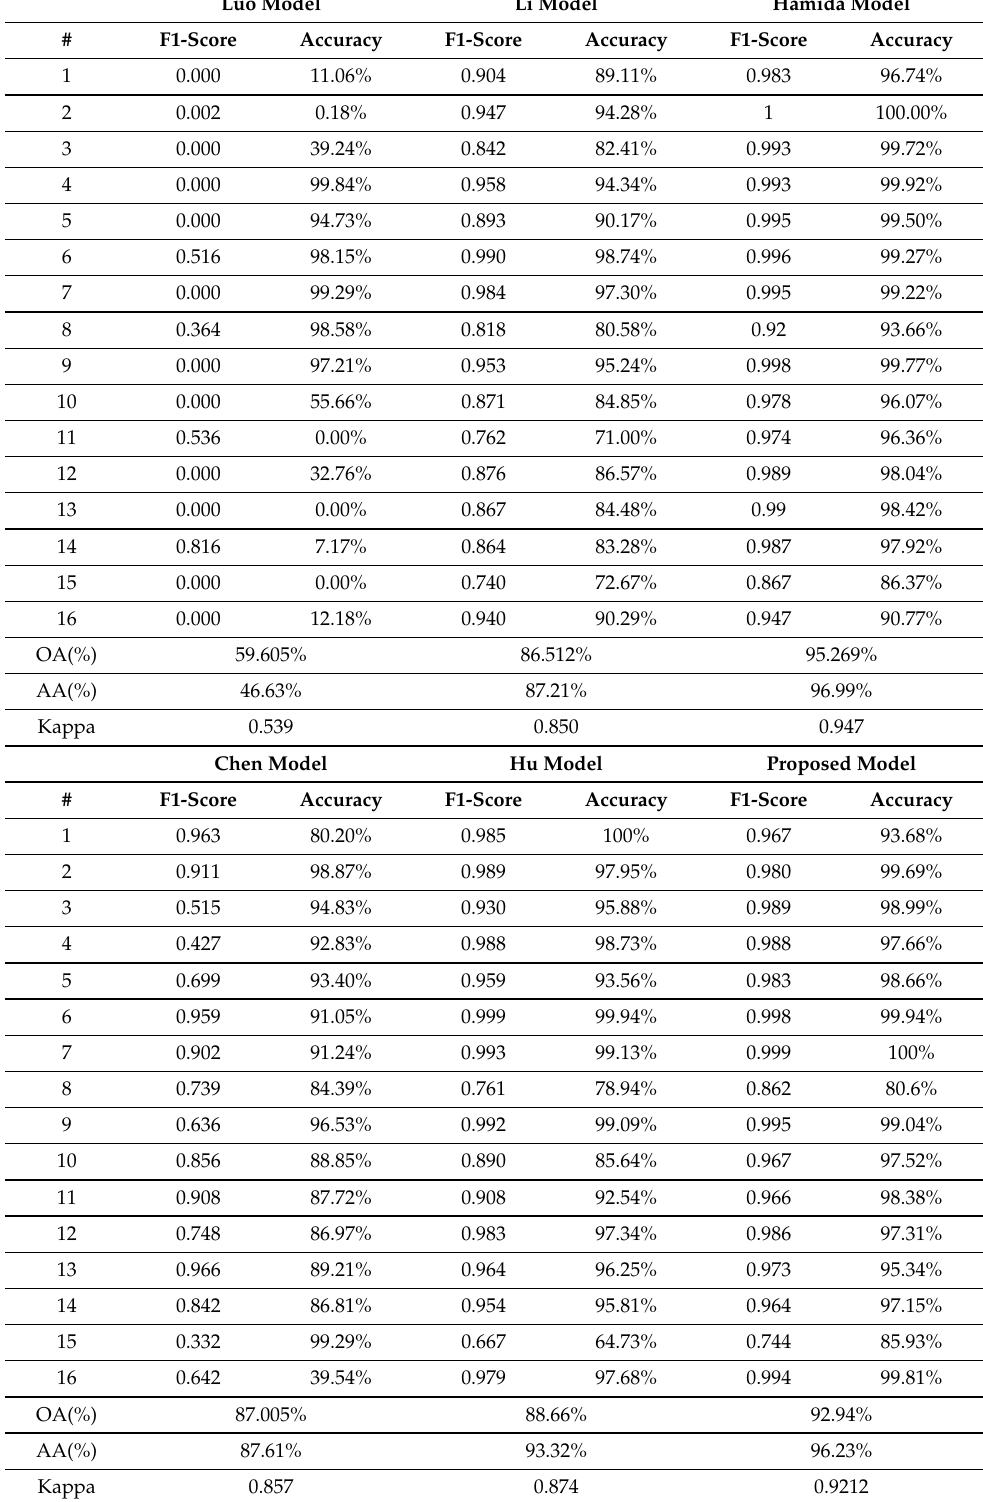
Table 7. Classification results of the Salinas dataset to which random spatial information is not